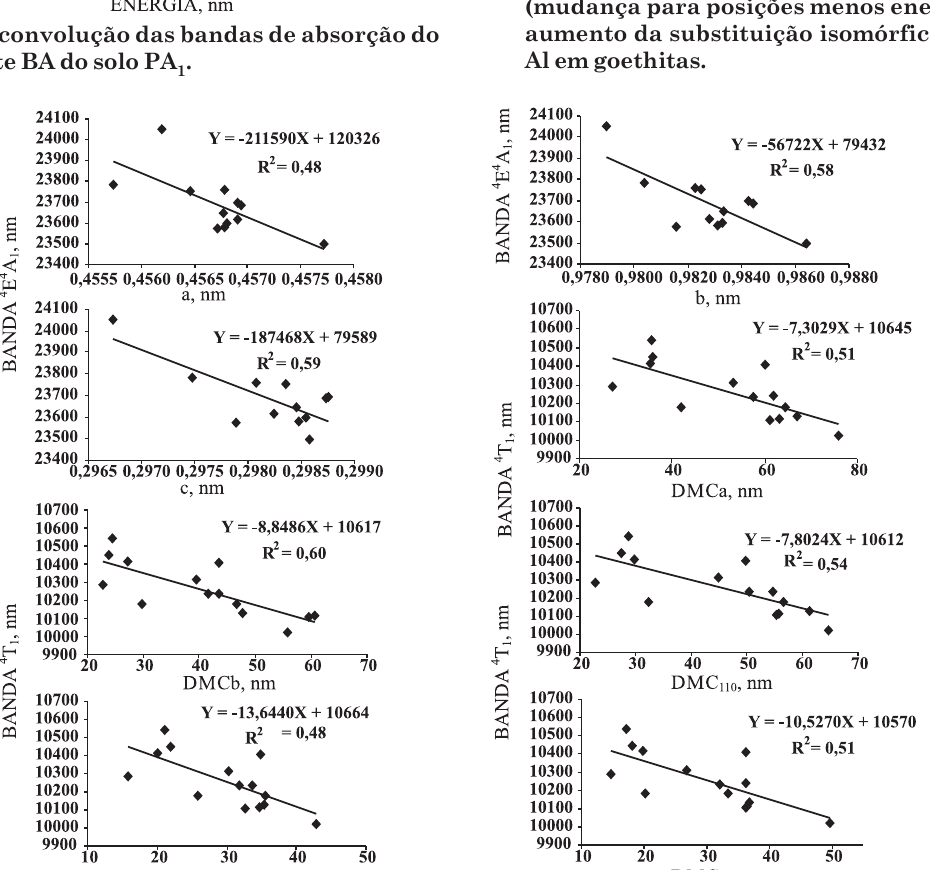
Figura 9. Relação entre a posição das bandas 4 T